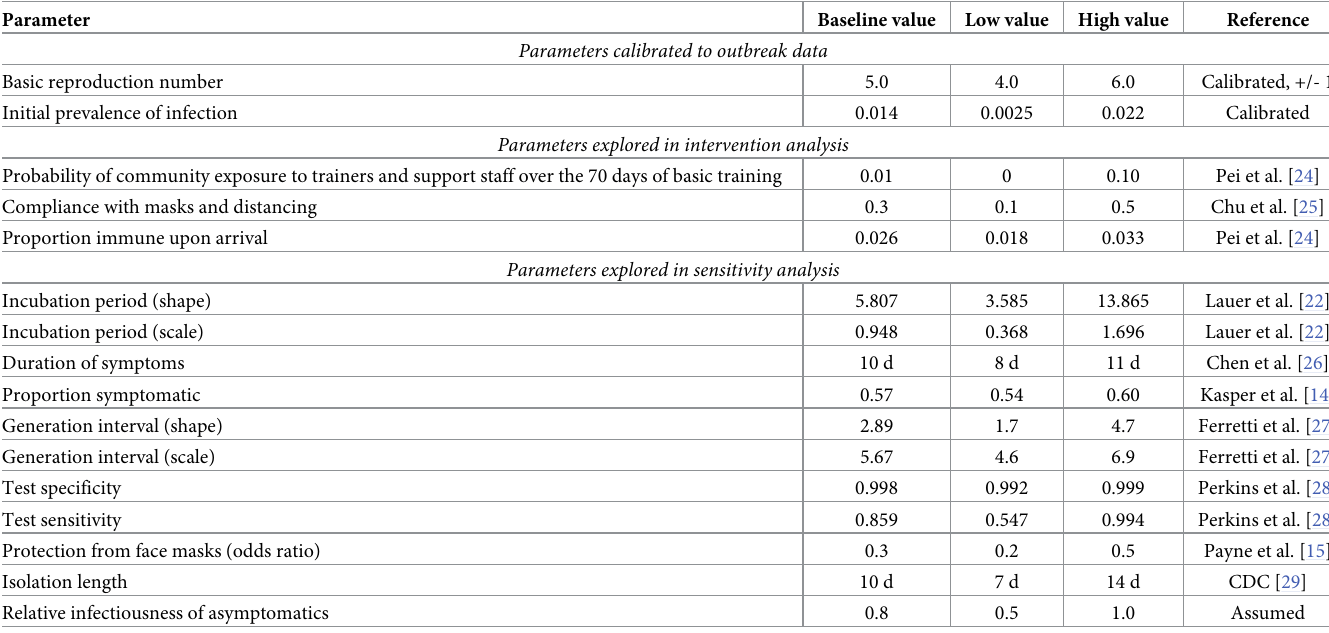
Table 1. Model parameters. For parameters for which references are cited, baseline values correspond to median estimates, and low and high values correspond to 2.5% and 97.5% quantiles, respectively. Isolation length is the only exception, which was chosen to span a range of values that have been considered at different